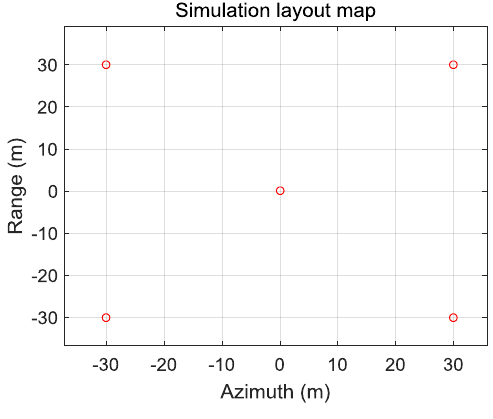
Figure 10. Simulation layout map.